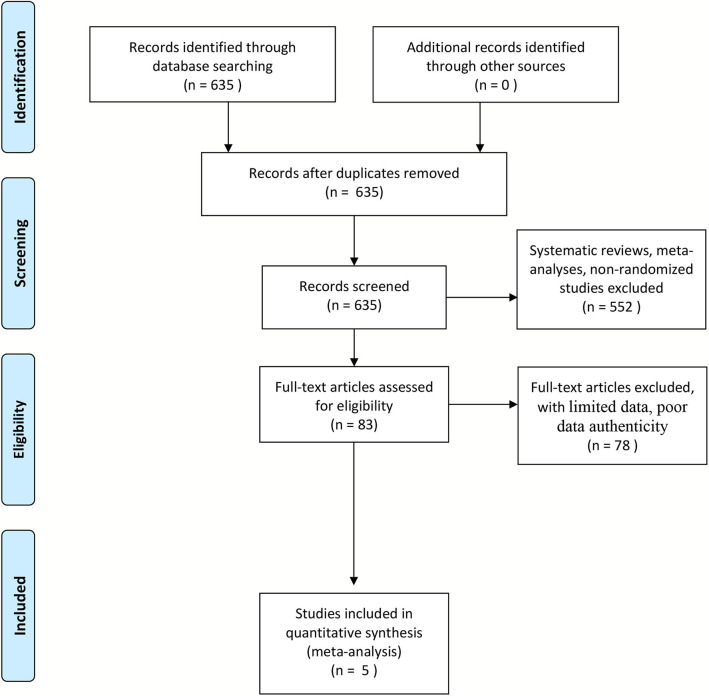
Flowchart of trial identification for meta-analysis.